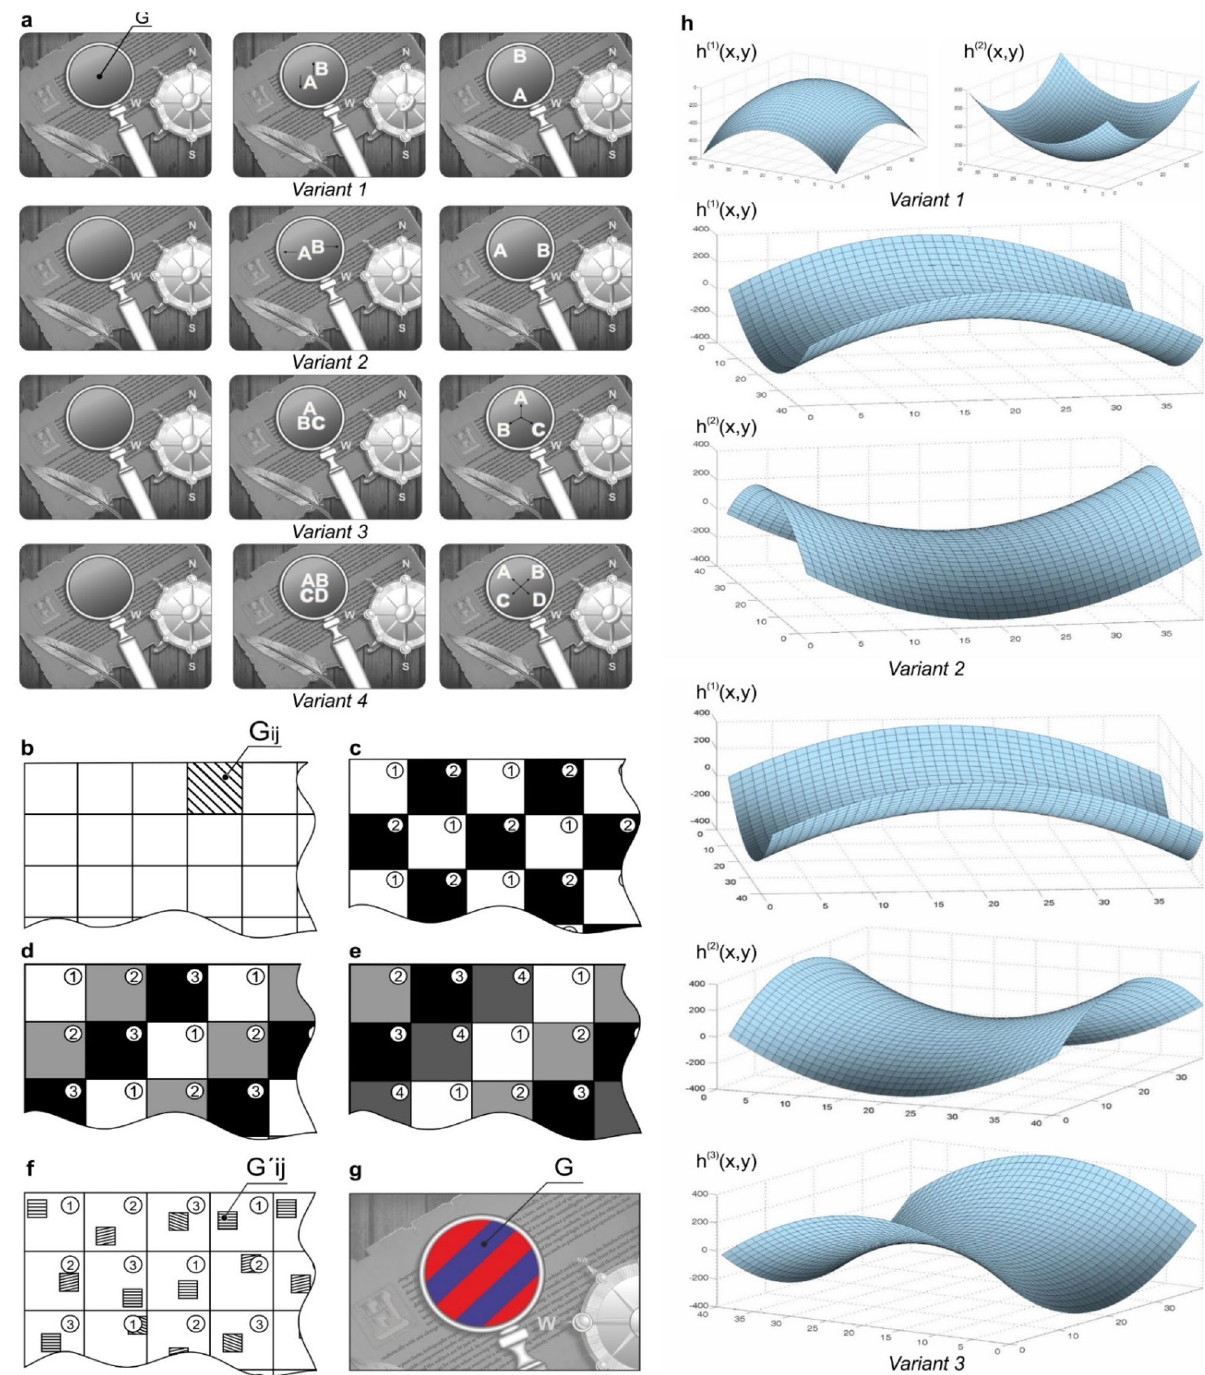
Figure 2. Design of the DOE in variants 1–4. ( a ) The design of the DOE when illuminated by scattered light (the left column) and the point source (the columns on the right). ( b ) The scheme of the partition of the DOE into elementary areas G ij . ( c ) The location map of two nonintersecting areas G (1) and G (2) in the area of optical element G. ( d ) The location map of three nonintersecting areas G (1) , G (2) , and G (3) in the area of optical element G. ( e ) The location map of four nonintersecting areas G (1) , G (2) , G (3) , and G (4) in the area of optical element G. ( f ) The location map of subareas G ′ ij in elementary areas G ij . ( g ) Complementary colour image seen at diffraction angles greater than 60°. ( h ) Plots of the function h (i) (x, y) for variants